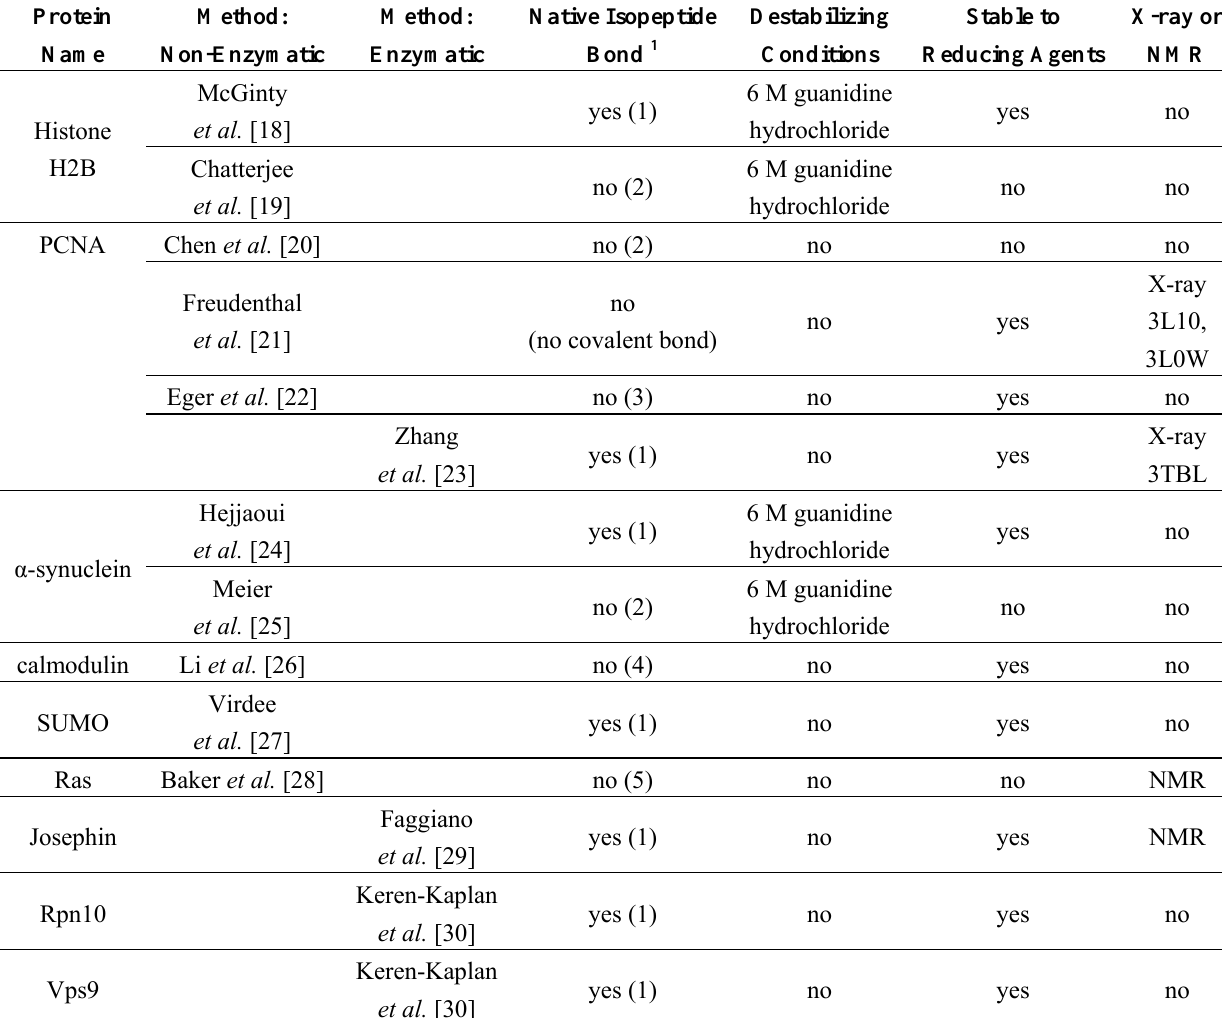
Table 1. List of the mono-ubiquitinated proteins produced in different studies for biochemical or structural investigation. In the columns, from left to right: name of the protein; reference to the bibliography with classification as non-enzymatic or enzymatic approach; type of connection between Ub and the linked protein; buffer conditions that could be critical for the extension of the method to unstable proteins; stability to treatment with reducing agents; availability of structural information obtained from the mono-ubiquitinated sample, either using X-ray crystallography or NMR. When explicitly indicated by the Protein Data Base (PDB) code, the structural coordinates are